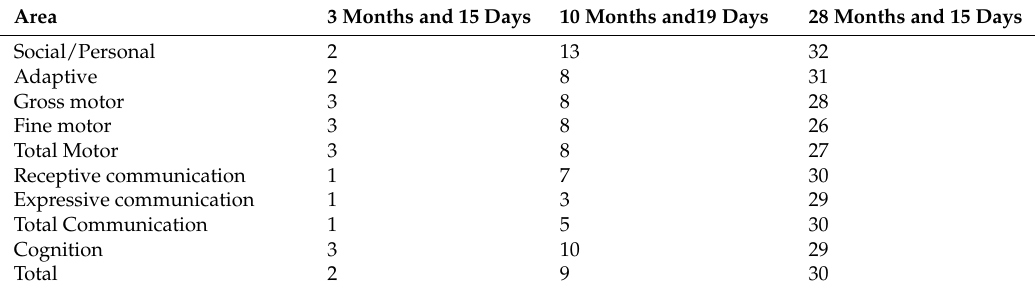
Table 2. Scores achieved in the Battelle Developmental Inventory Screening Test (BDIST) at admission (3 months and 15 days), after 7 months of treatment (10 months and 19 days) and 14 months (28M15d) after Discharge. Note the improvements in practically all areas of the test during the treatment, but also the marked increase in these scores observed when the patient came for a revision 14 months after discharge, so that despite the fact that the patient was 28 months and 15 days old, his age of development corresponded to 30 months.